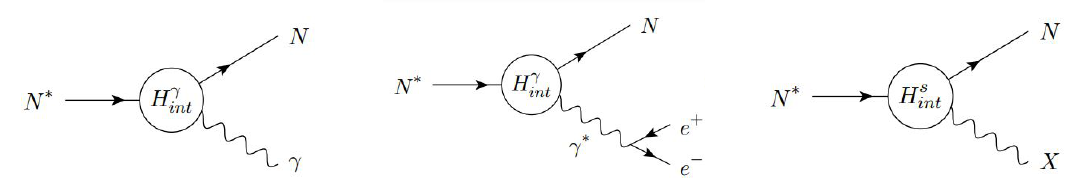
Figure 3 . Real γ -emission (left), IPC (center) and real X -emission (right) processes for the excited N ∗